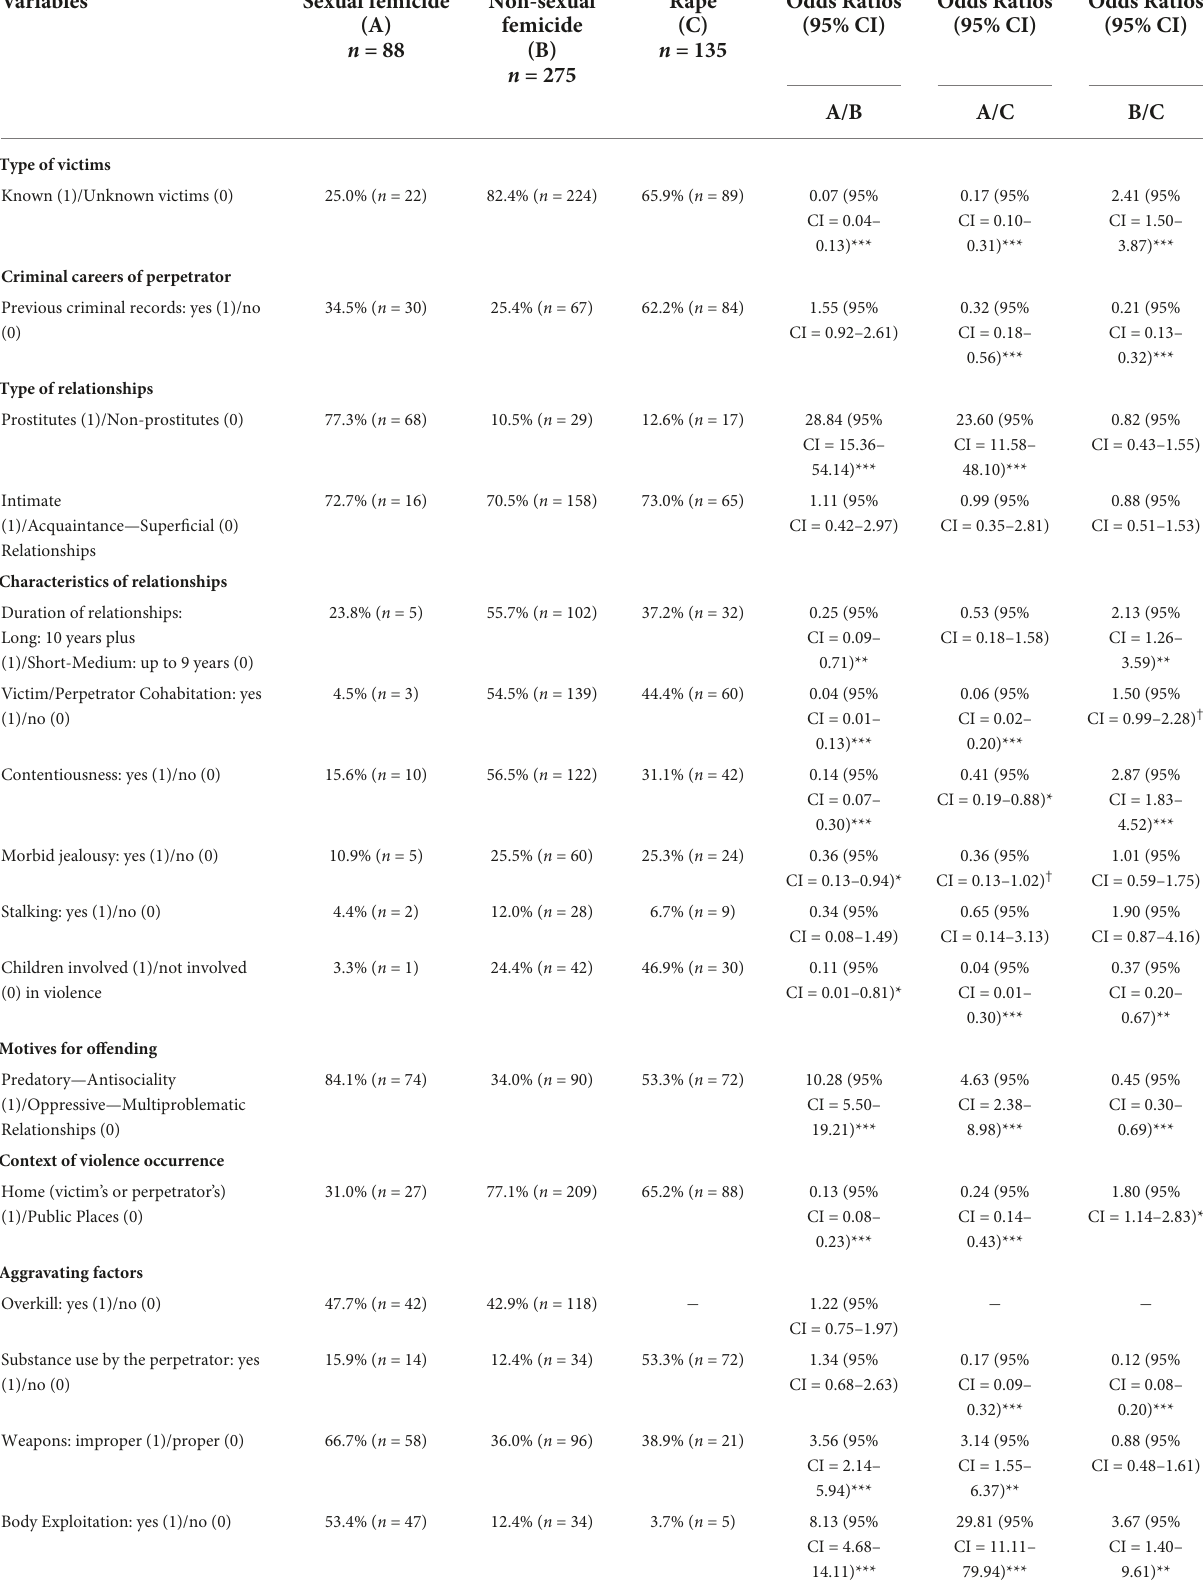
TABLE 3 Comparisons of sexual femicide versus non-sexual femicide versus rape.